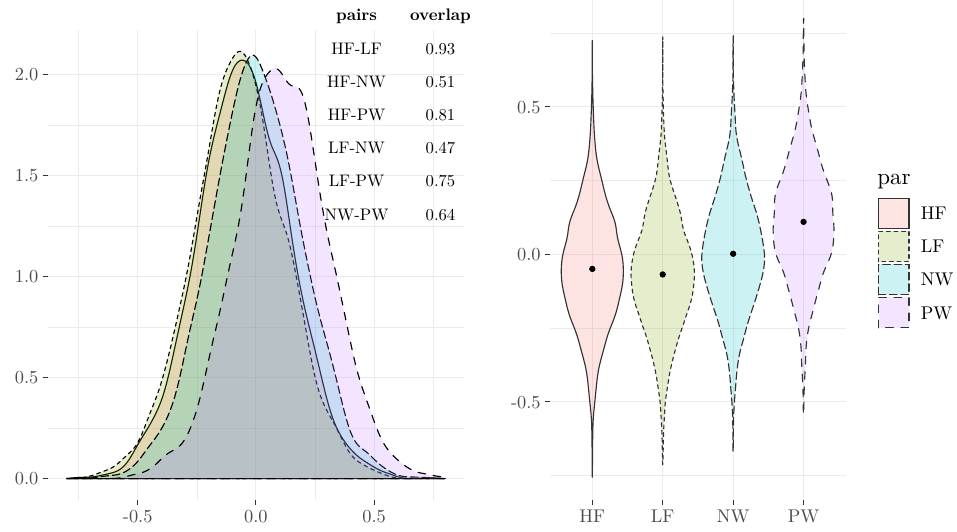
Figure 5. Illustrative example: Marginal posterior densities and violin plots for the levels of condition (recoded via dummy code). Note that black dots represent posterior means of the parameters γ whereas overlaps have been computed via the package overlapping